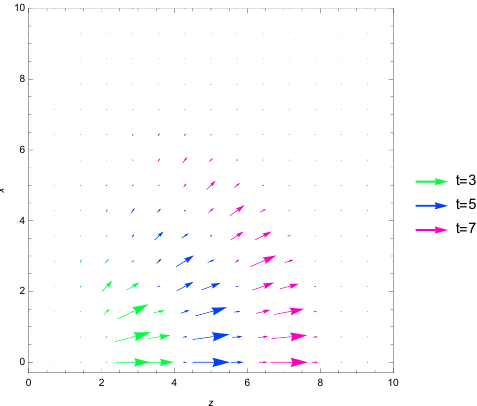
Figure 5 : Direction of the bulk Poynting vector for fixed time. The numerical values A = 1 and L = 1 have been